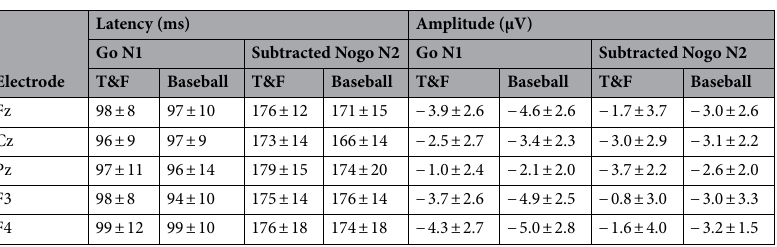
Table 2. The peak latency and amplitude ± S.D of auditory Go N1 and subtracted Nogo